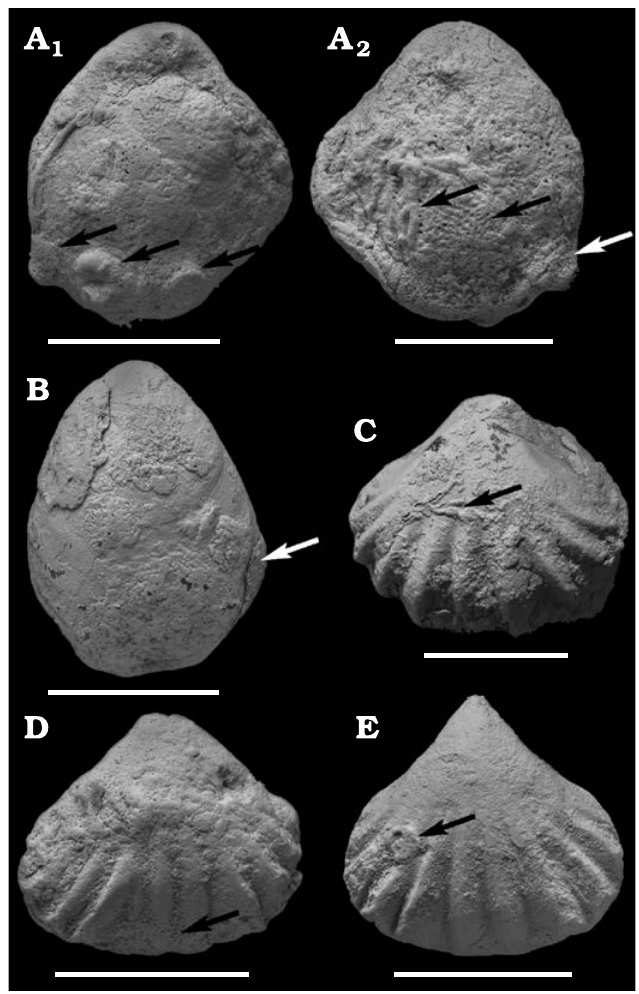
Fig. 3. Encrusting sclerobionts (arrowed) on different brachiopod Roadian specimens from Monte Redondo loca lity, Chiapas, Mexico. A . Com posita hapsida Stehli and Grant, 1970, IGM 11150, A 1 with holdfast of crinoid and two microconchids (left to right arrows); A 2 with hederelloids (left black arrow), bryozoans (right black arrow), and holdfast of crinoid (white